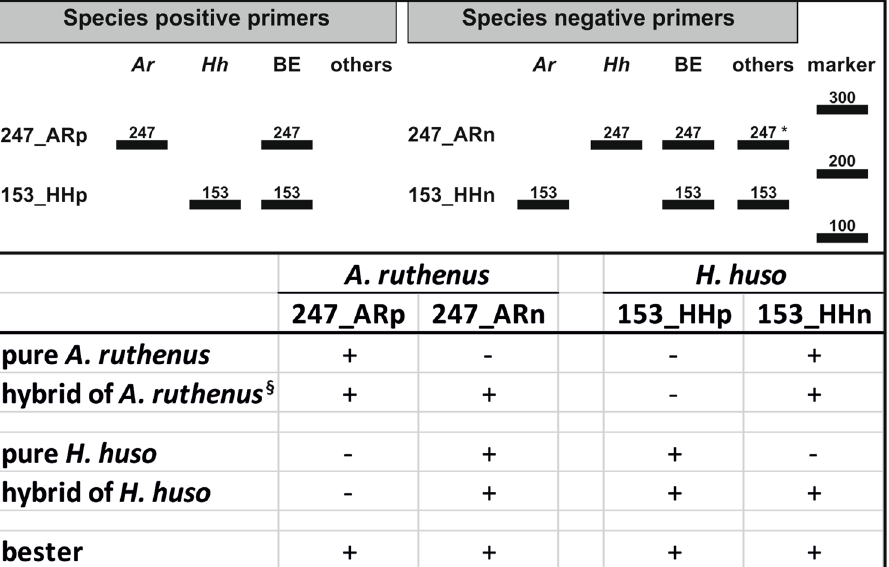
Figure 3. Expected band patterns for identification of H . huso ( Hh ), A . ruthenus ( Ar ), bester (BE), and for other tested species (others), using A . ruthenus and H . huso positive and negative primers. + = positive amplification; − = negative amplification. * Positive amplification of 247 bp band was obtained only in 57,5% samples of A . stellatus ; § except hybrid between A . ruthenus and A . stellatus